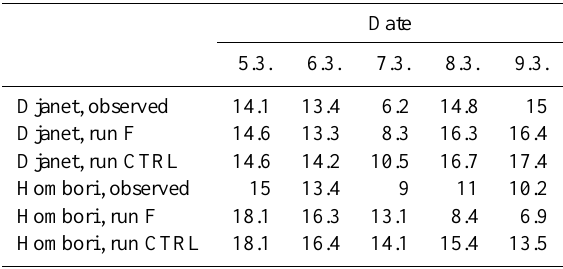
Table 4. Observed and simulated daily temperature range (DTR) in K for Djanet and Hombori.